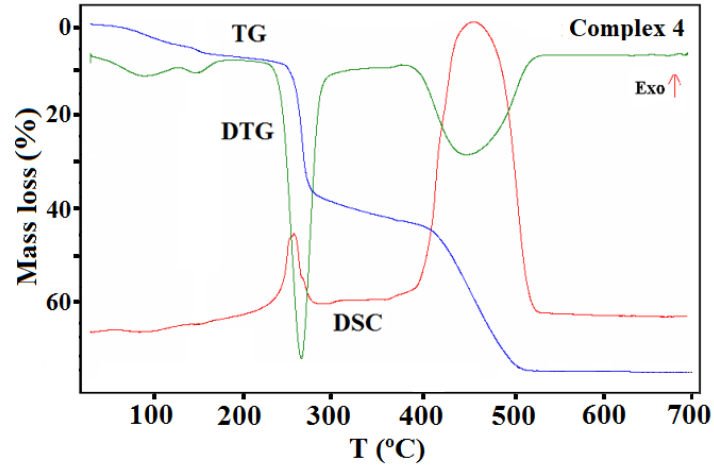
Figure 15. FTIR spectra of gaseous products evolved during the decomposition process of 3. Crystals 2020 , 10 , x FOR PEER REVIEW